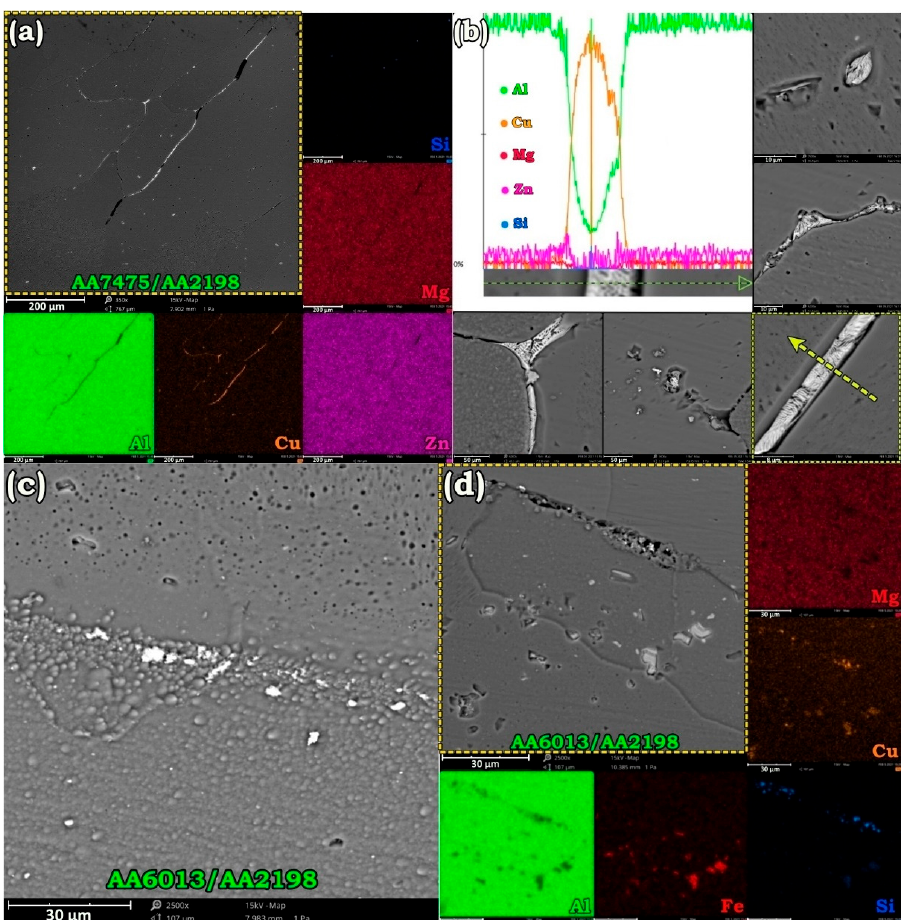
Figure 4. Formation of Al-Cu eutectic phase in AA7475-AA2198 weld specimen by annealing at 540 °C ( a , b ) and second-phase particles around welding interface of AA6013-AA2198 by annealing at 460 °C ( c ) and 540 °C ( d